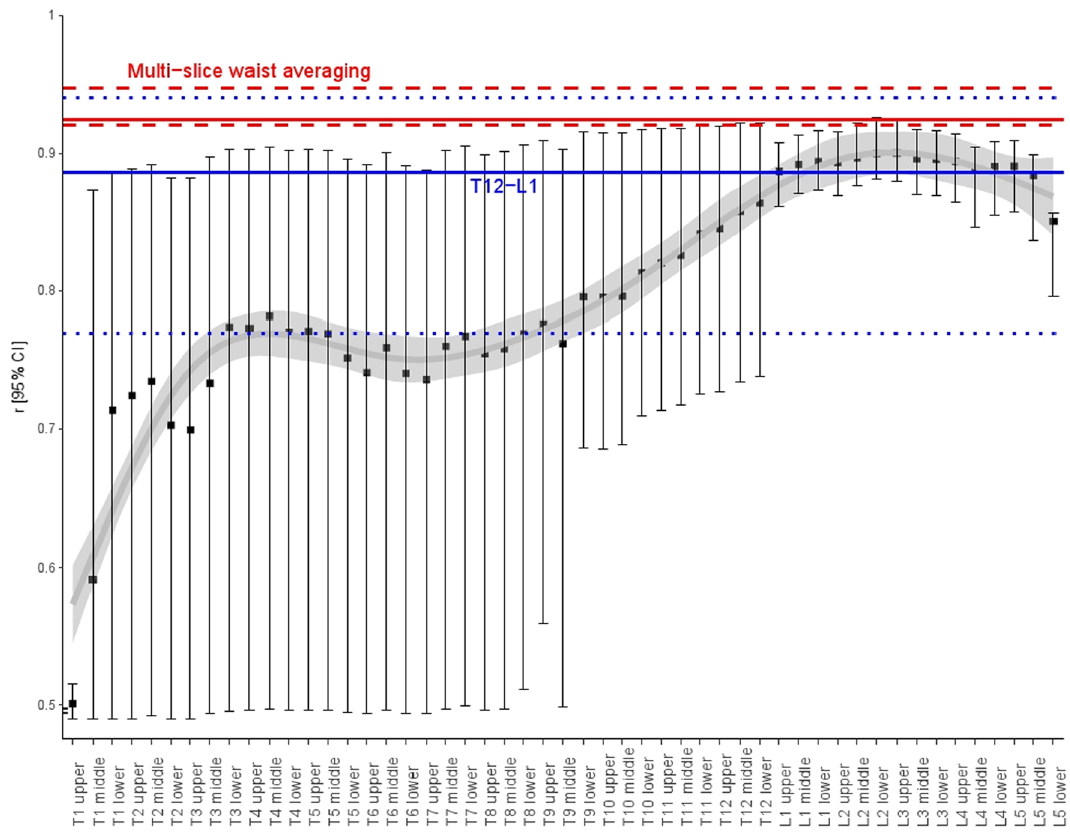
Fig. 5 Bar graph plotting correlation coefficients for whole‑body composition after standardizing muscle, visceral fat, and subcutaneous fat measurements by sex and confidence intervals based on 1000 bootstrap